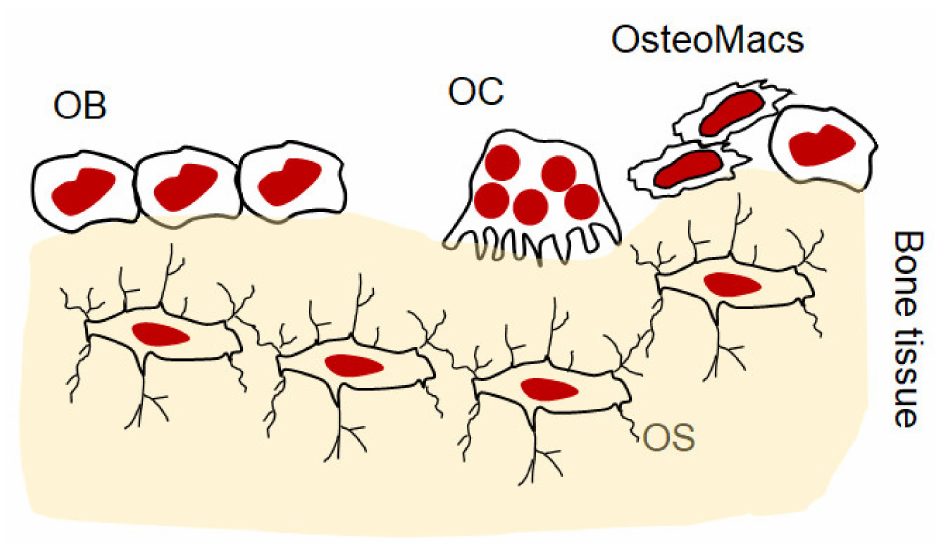
Figure 1. Schematic diagram illustrating the cellular entities in bone microenvironment. OB: os- teoblast, OC: osteoclast, OS: osteocytes, osteomacs: osteal macrophage. 2.1. Osteoclastogenesis and Physiological and Pathological Functions of